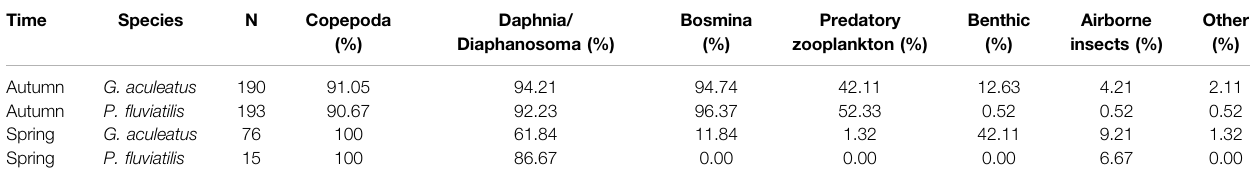
TABLE 2 | The frequency of occurrence (according to Hyslop, 1980) indicates the percentage of sampled sticklebacks and perch from Lake Constance consuming each type of prey. Time Species N